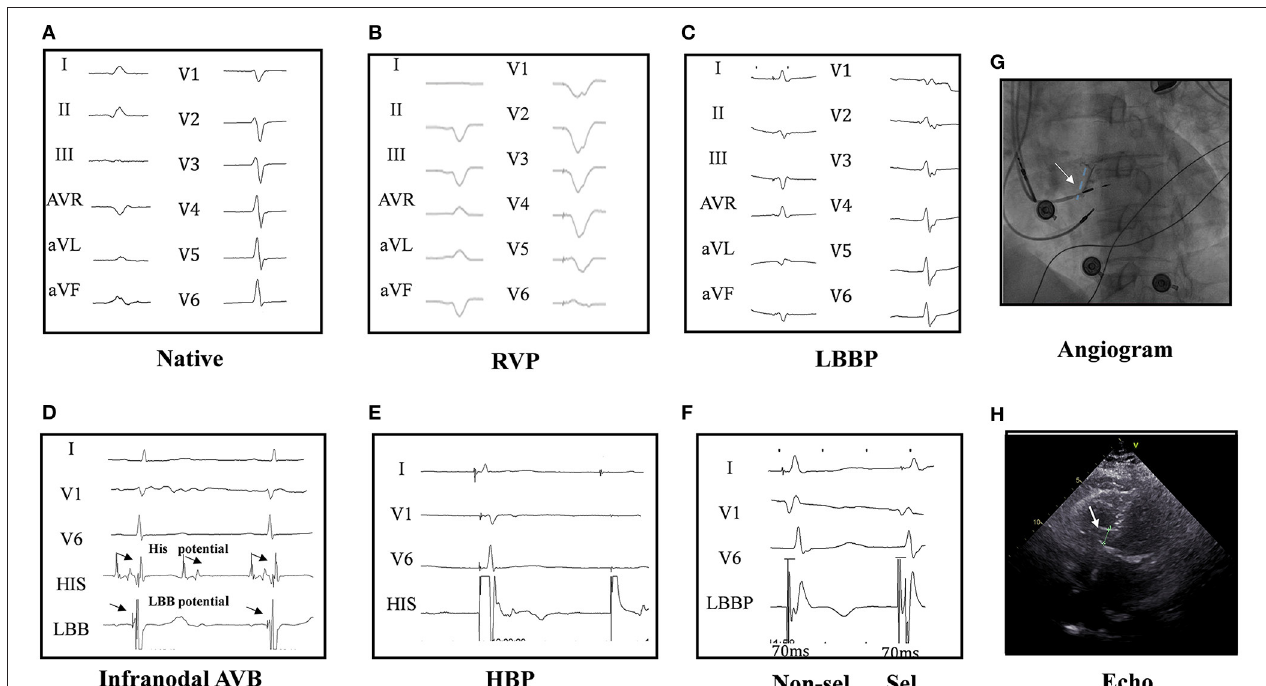
FIGURE 1 | Twelve-lead ECG and intracardiac electrogram (EGM) in a patient. The native cardiac rhythm (A) ; twelve-lead ECG by right ventricular pacing (RVP) (B) ; the ECG by left bundle branch pacing (LBBP) (C) ; narrow ECG QRS with LBB potential in intracardiac electrograms (EGM at the bottom) in a infranodal atrioventricular block (AVB) patient (D) . His bundle pacing (HBP) could not pace beyond the block site (2.5V at 0.4ms) (E) . Selective (0.6V at 0.4ms) and non-selective (0.5V at 0.4ms) LBBP (F) and the angiogram of the sheath to assess the depth of the LBB LBBP lead (G) are shown. Echocardiography showed the lead was fixed in the left ventricular septum (H) , and LBBP but not HBP could pace beyond the block site in one patient of AVB with infranodal block. HBP at 2.5 V/0.4ms could induce the loss of capture (2:1) (E) , while LBBP could induce pacing (1:1) (F) , indicating LBBP but not HBP could pace beyond the block site in infranodal AVB patients. His and LBB potential were seen in the pacing location (D)